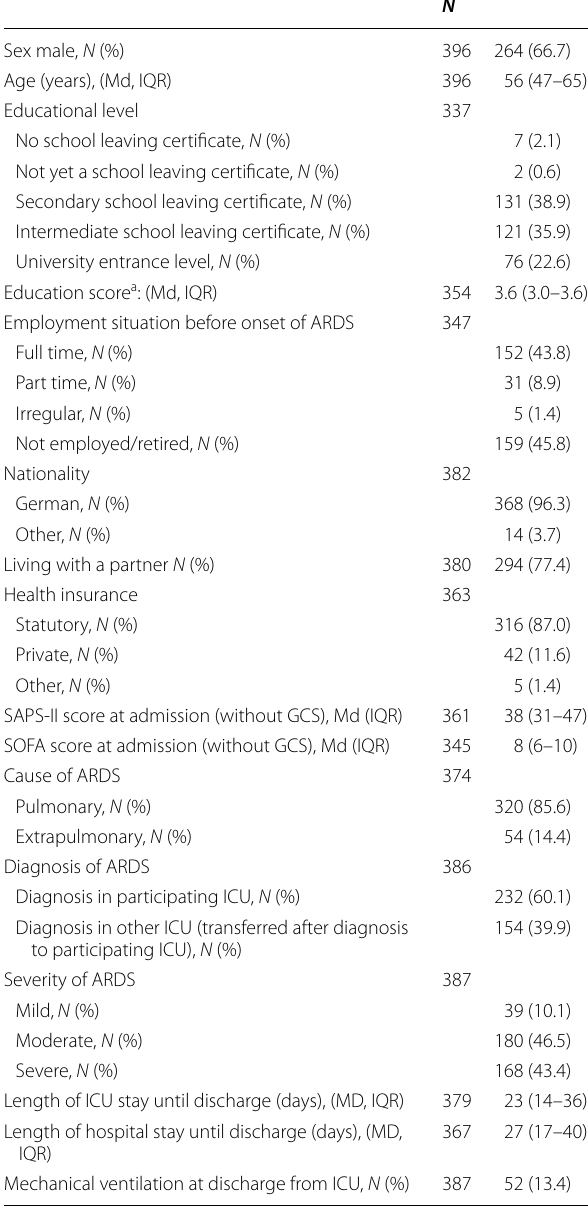
Table 1 Sociodemographic and disease-related characteristics of study participants ( N 396 respondents at 1-year =